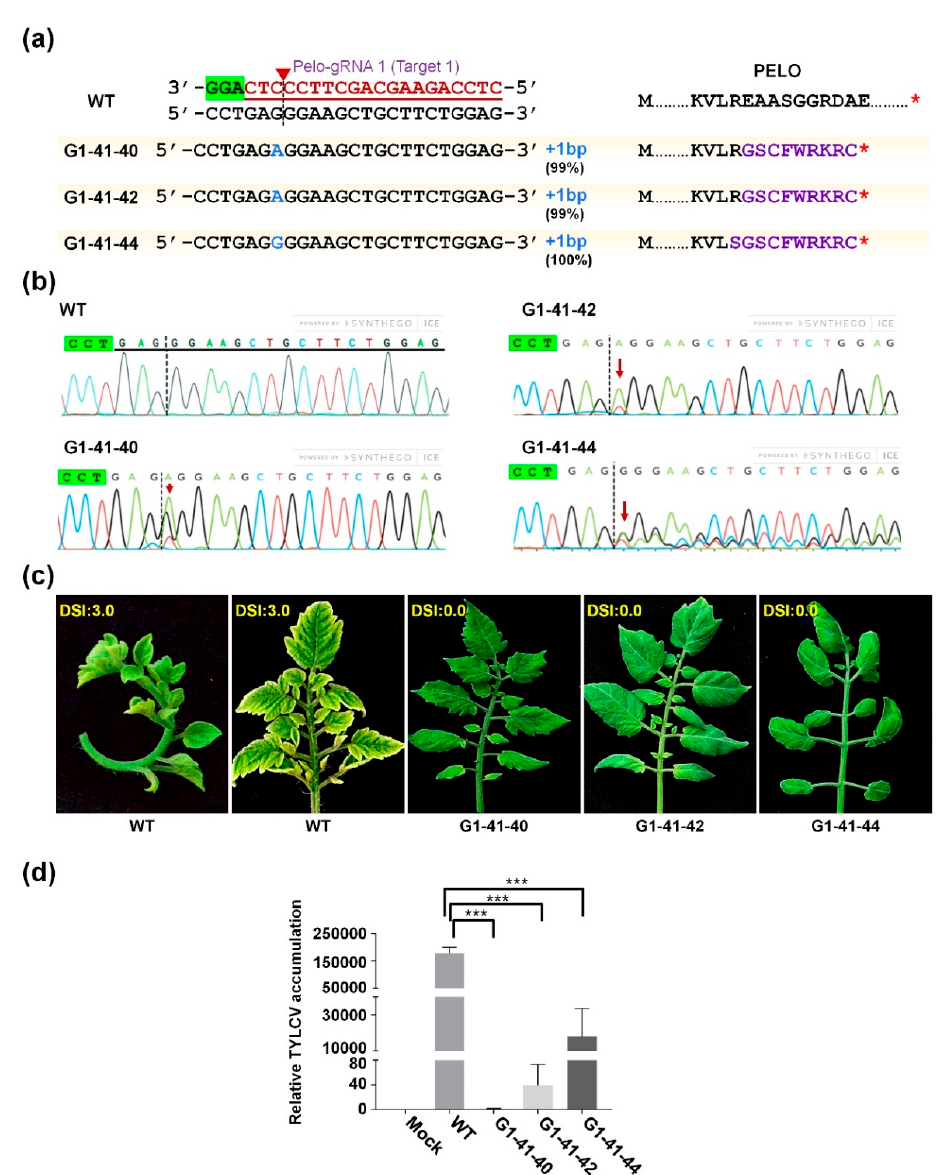
Figure 3. Generation of CRISPR/Cas9-mediated SlPelo genome-edited tomato lines resistant to Tomato yellow leaf curl virus (TYLCV). ( a ) Target site sequences in the wild-type (WT) and three SlPelo -knockout G1 plants (G1-41-40, G1-41-42, and G1-41-44) showing the mutation pattern with 1 bp insertion (blue) at the SpCas9 cleavage site. The knockout efficiency (%) of individual lines was evaluated using the Inference of CRISPR Edits (ICE) tool. The right panel shows WT and truncated PELO amino acid sequence, separately. The altered amino acid sequence is depicted in purple and stop codon is depicted as a red star; ( b ) Chromatograms showing the mutant SlPelo alleles (red arrow). The dotted line depicts the sgRNA cleavage position; ( c ) Resistance analysis of SlPelo mutant lines tested for TYLCV pathogenicity. The phenotype of the G1 tomato plants evaluated at 28 days post-infection (DPI) with TYLCV-virulent factor. According to visual TYLCV symptoms, the Disease Severity Index (DSI) was calculated from three replicates; ( d ) Relative DNA amounts of TYLCV in WT and mutant tomato plants germinated from leaves collected from TYLCV-inoculated tomatoes. Individual samples (three biological replicates) for each plant were used for analysis. Relative TYLCV DNA amounts were normalized against the tomato SlEF1 α gene as an internal control. Data analyses were conducted using the 2 − ∆∆ Ct method. Error bars represent standard error (SE). Data represent three biological replicates. Asterisks indicate statistically significant differences (*** p < 0.0001, independent samples t